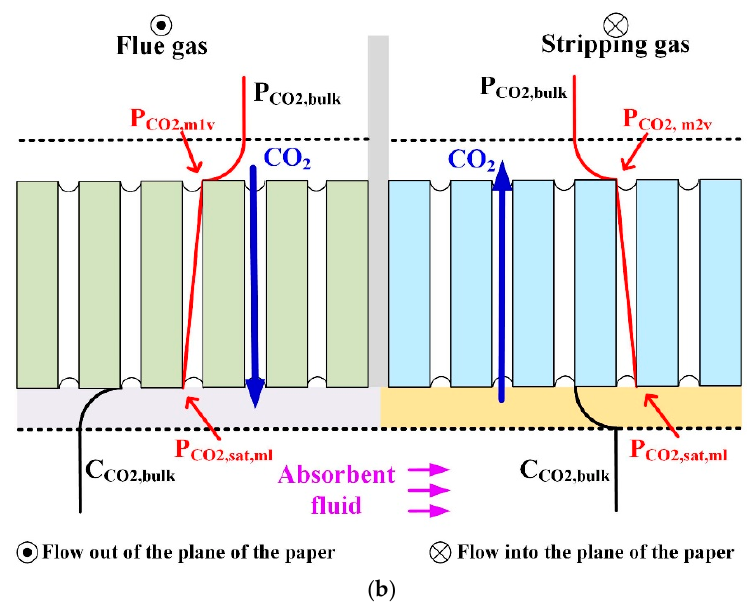
Figure 4. Mass transfers in ( a ) parallel-flow and ( b ) cross-flow HASMCs.